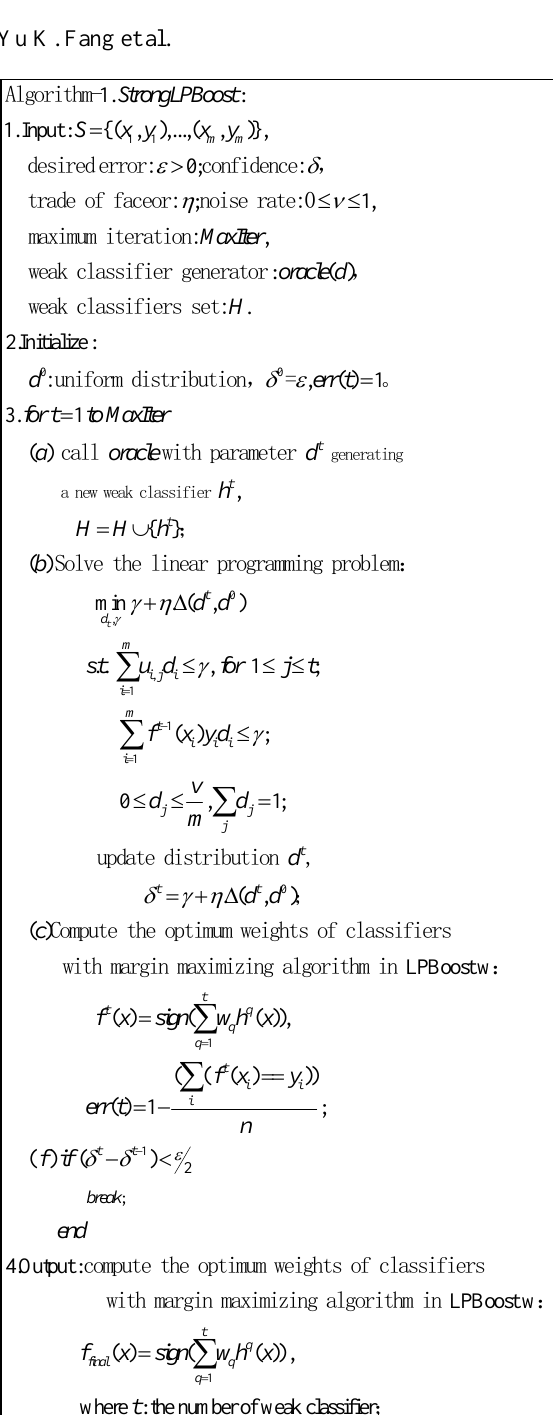
compute the optimum weights of classifiers with margin maximizing algorithm in ： )), where :the number of weak classifier Fig. 2. StrongLPBoost algorithm